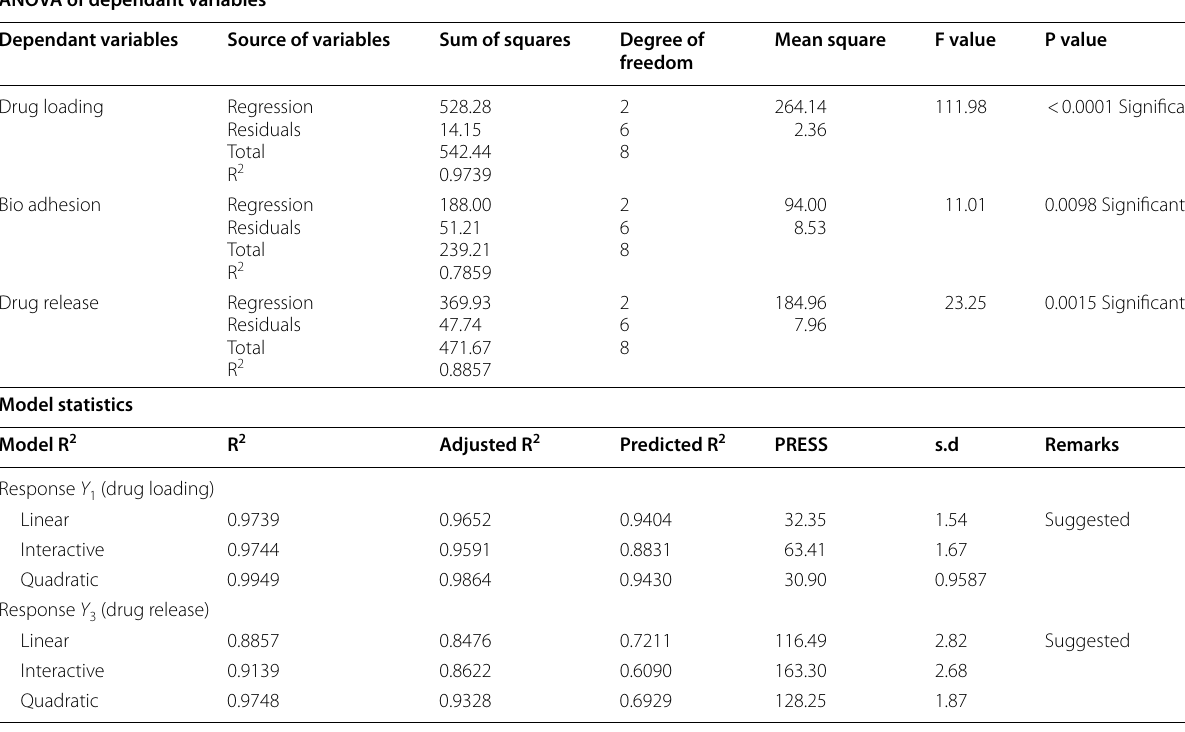
Table 2 Model statistics for responses ANOVA of dependant